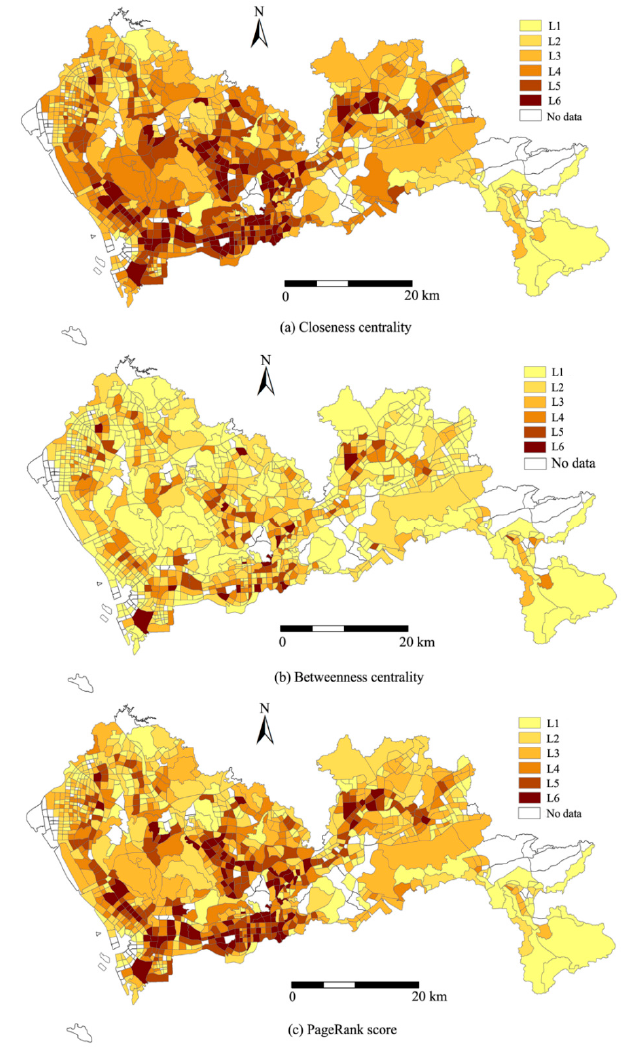
Figure 11. Spatial distribution of closeness centrality, betweenness centrality, and PageRank score of the TAZs.